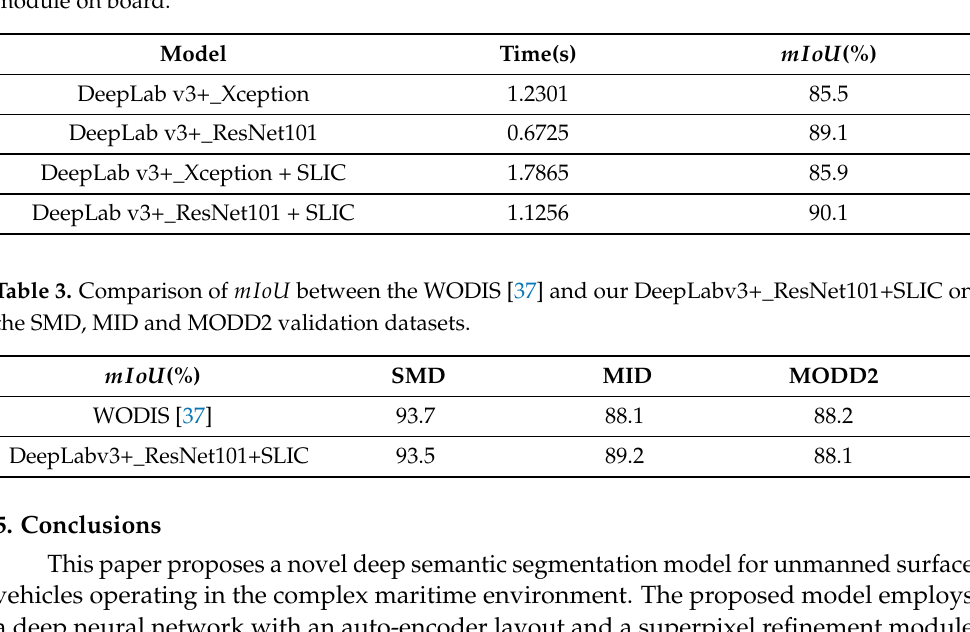
Table 2. DeepLab v3+ network and the average inference time and mIoU with the SLIC algorithm module on board.